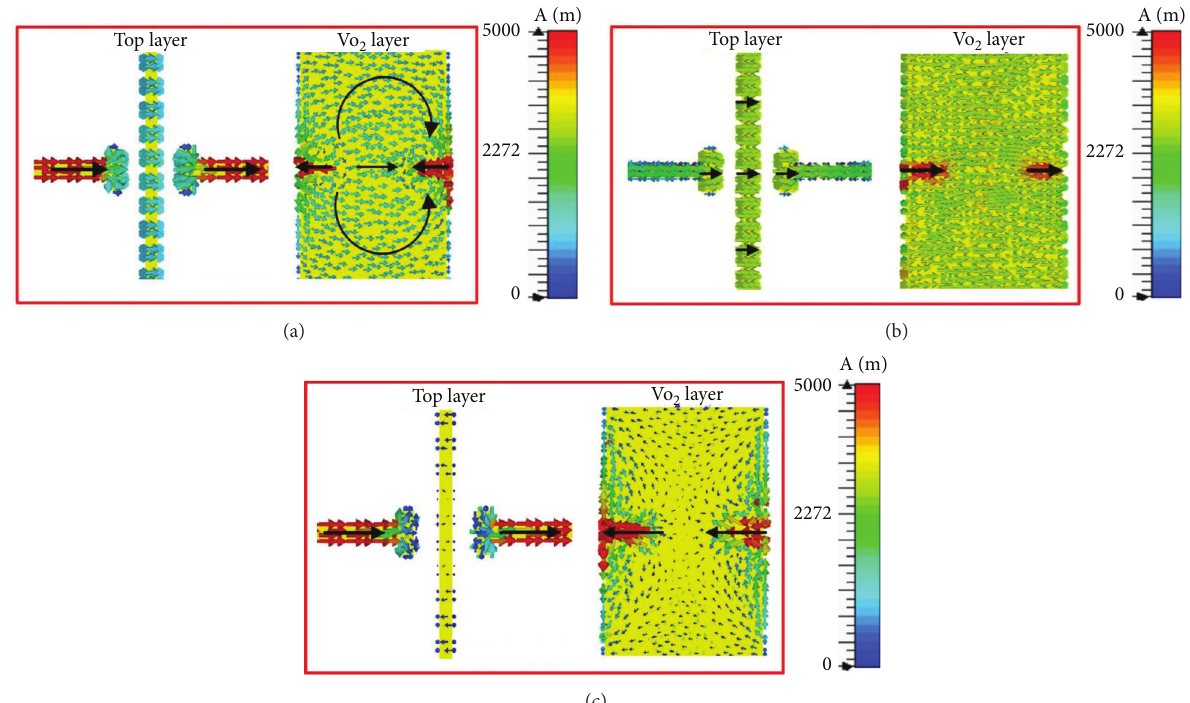
Figure 5: Surface current distribution of the device when VO (c)